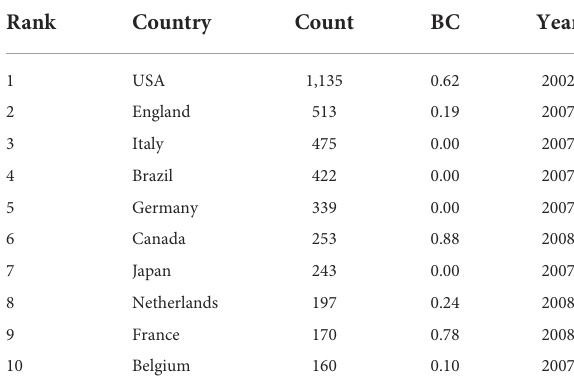
TABLE 1 Top 10 countries in terms of number of published CPET